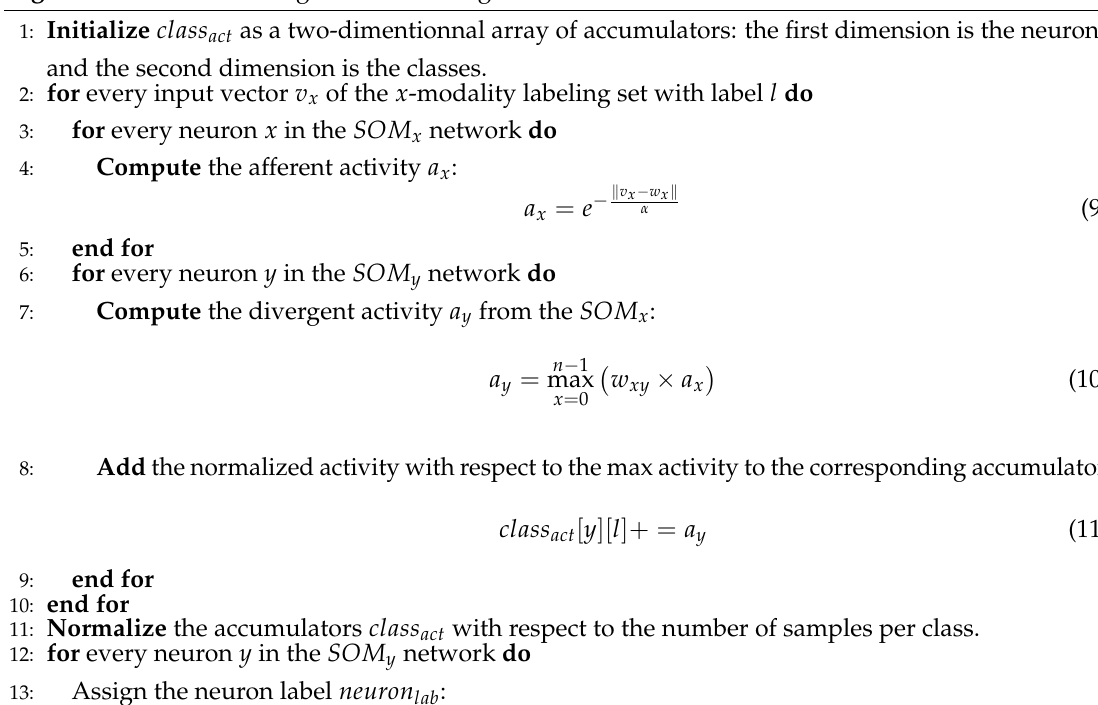
Algorithm 3 ReSOM divergence for